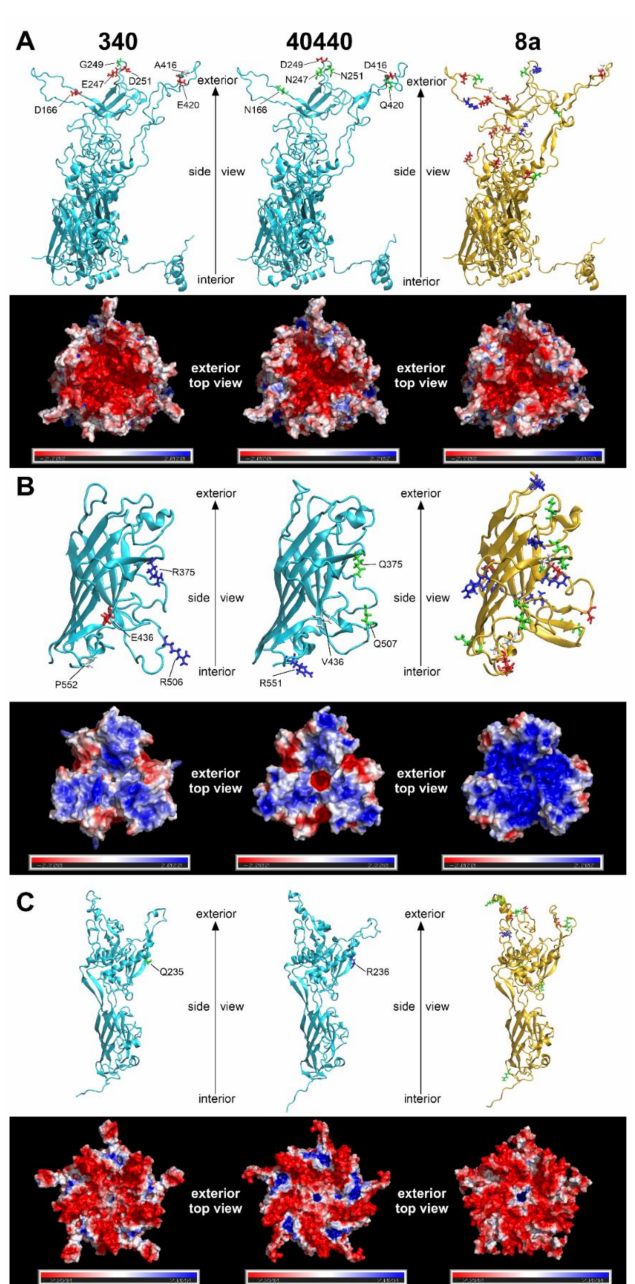
Figure 3. Three-dimensional major capsid protein models of strains 340 and 40440 (both serotype fowl adenovirus 5 [FAdV-5]) and FAdV-8a: ( A ) complete hexon; ( B ) fiber knob (amino acid stretches for strain 340: 349–553, 40440: 349–554, FAdV-8a: 314–524); and ( C ) penton base (amino acid stretches for strain 340: 76–542, 40440: 77–543, FAdV-8a: 81–552). The upper strips of each subset show the monomer subunits in cartoon representation; here, amino acid substitutions affecting the electrostatic charge of the protein are highlighted. For strains 340 and 40440, substitutions compared to each other, and for fowl adenovirus 8a, substitutions compared to strain 340, are highlighted. Red and blue are charged (negatively and positively, respectively), green are polar, and white are nonpolar amino acids. The lower strips of each subset represent the electrostatic surface potentials of the trimeric (hexon and fiber knob) or pentameric (penton base) proteins, where red color represents regions with a potential value below − 2.0 kT, white represents 0.0 kT, and blue represents regions above +2.0